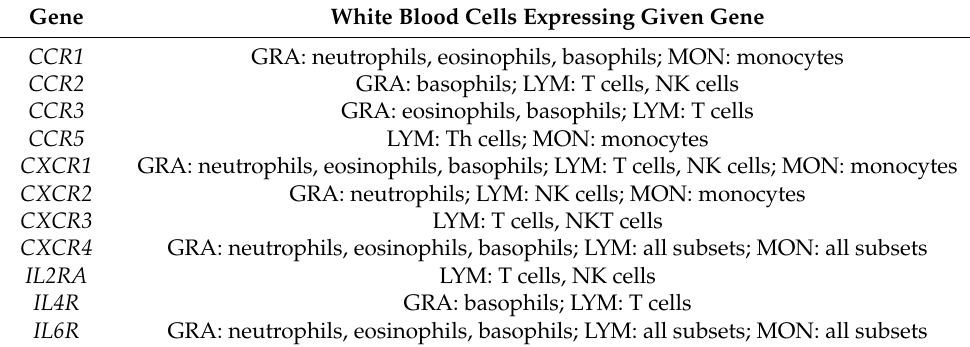
Table 1. White blood cells expressing analyzed genes encoding receptors for chemokines and interleukins